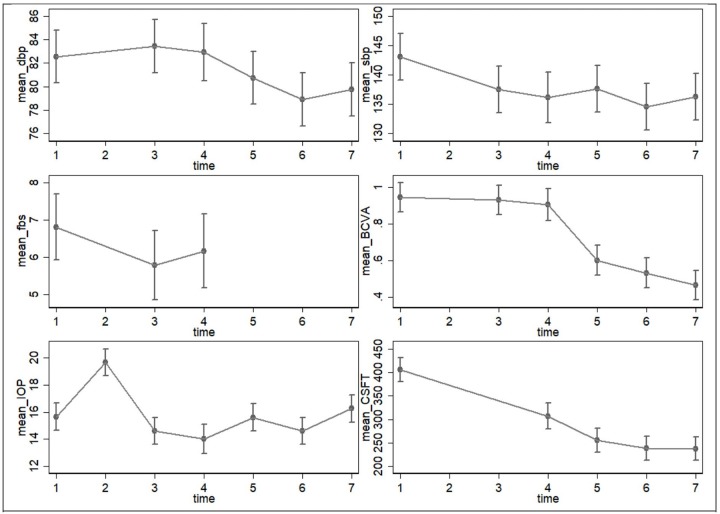
Mean change in clinical parameters over time with 2 standard error margin.1 = baseline, 2 = 30 minutes post-injection, 3 = day 1, 4 = day 7, 5 = 4 weeks, 6 = 8 weeks, 7 = 12 weeks, BCVA = best corrected visual acuity, CSFT = central sub-field fovea thickness, dbp = diastolic blood pressure, fbs = fasting blood sugar, IOP = intraocular pressure, sbp = systolic blood pressure.